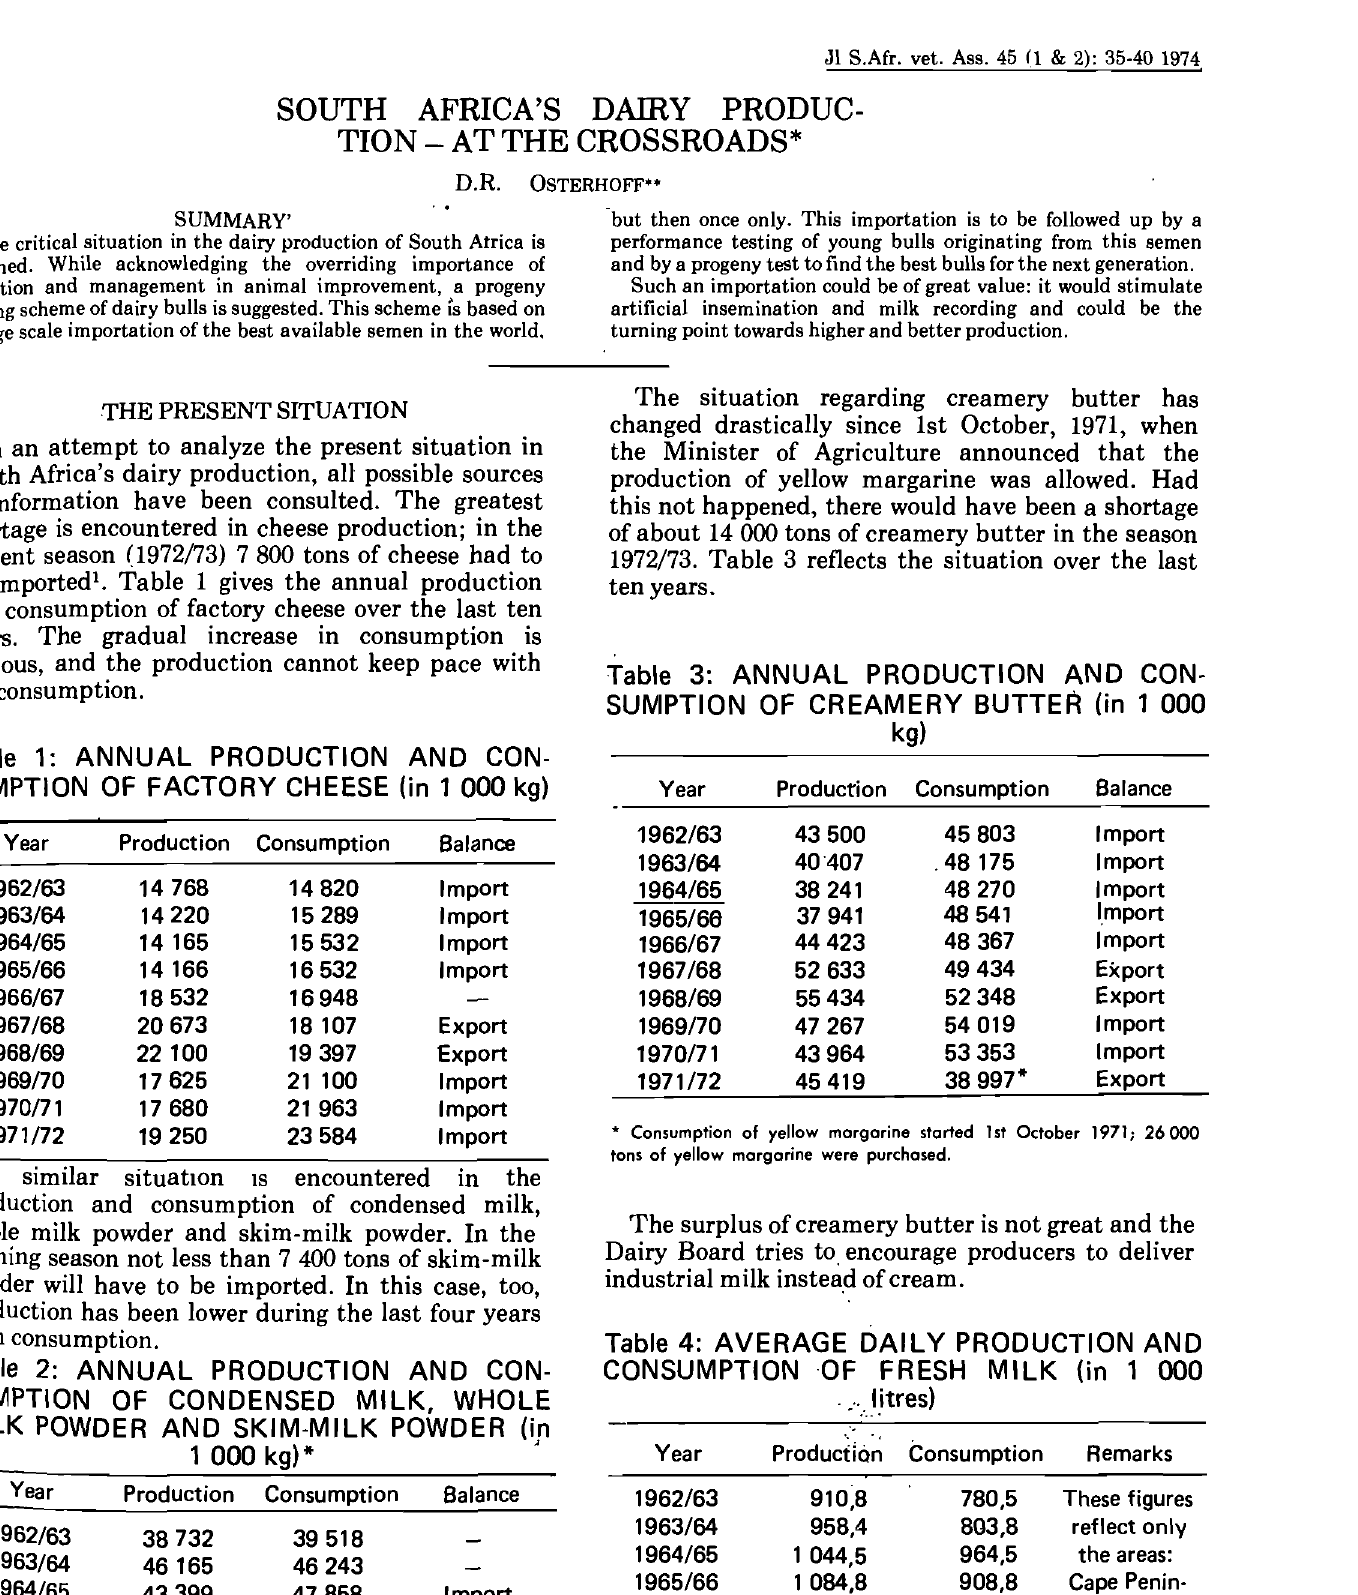
Table 4: AVERAGE DAILY PRODUCTION